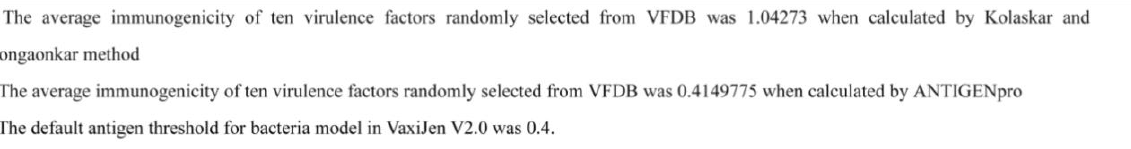
Figure 2. Pan-genome analysis of twenty-one Mhp strains and the immunodominant antigen selec- tion. ( A , B ) Summary statistics of Mhp pan-genome analysis results; 408 core genes were identified and mapped to Mhp strain 232 genome to find the core proteins. ( C ) Changes in protein quantity during the screening processes included pan-genome analysis, host homologous protein removal, subcellular localization, and virulence factor database alignment. ( D ) The immunogenicity of the four immunodominant antigens was calculated by Kolaskar and Tongaonkar method, ANTIGENpro, and VaxiJen V2.0.